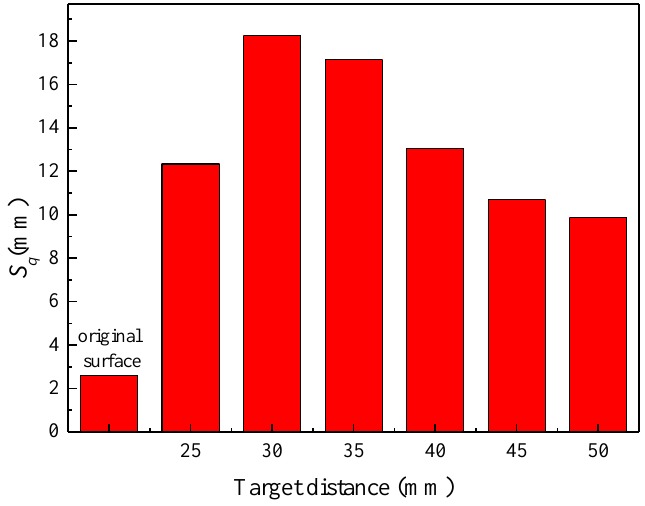
Figure 12. Variation in RMS roughness of the sample surface with target distance.